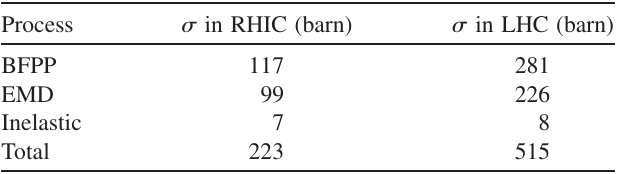
TABLE III. Interaction cross sections (cid:9) in RHIC and LHC for different processes removing ions from the beam. Values are taken from Refs. [2,26,27,29]. The EMD cross sections include all decay